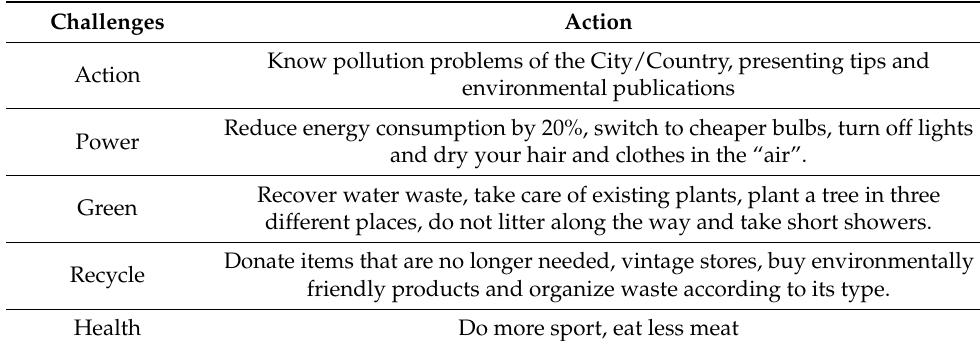
Table 3. Challenges established through gamification